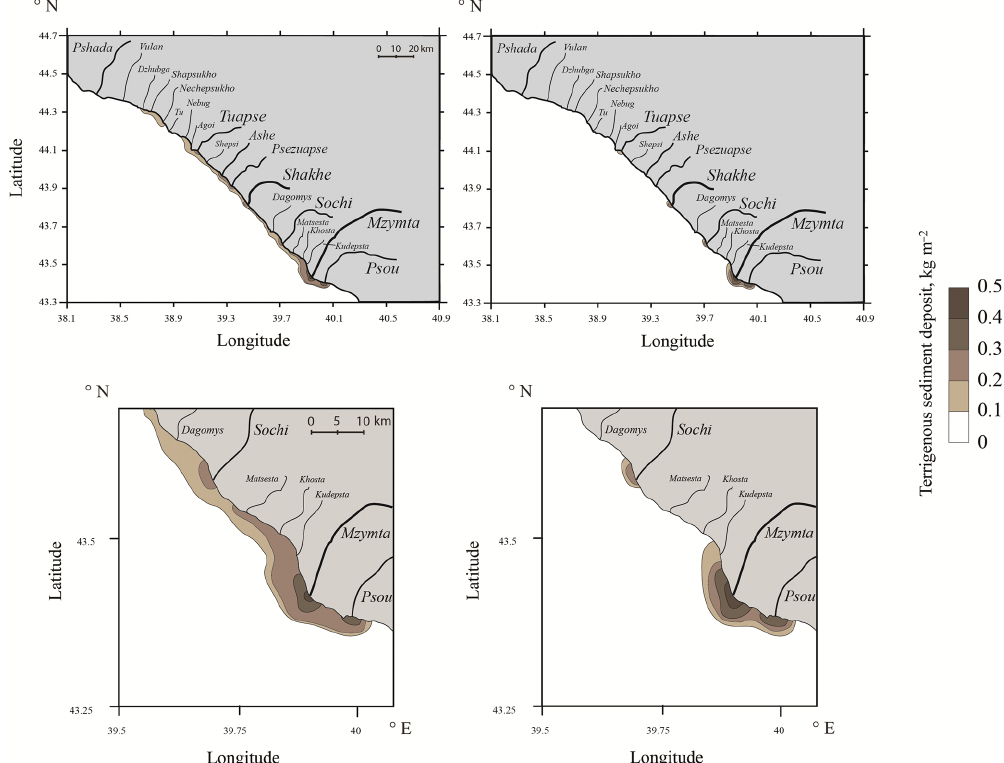
Figure 13. Simulated distribution of terrigenous sediments discharged from the rivers of the study area during 25 May to 4 July 2011 and deposited on the seabed at RCBS (top panel) and its southern part (bottom panel) under the real (left) and averaged (right)